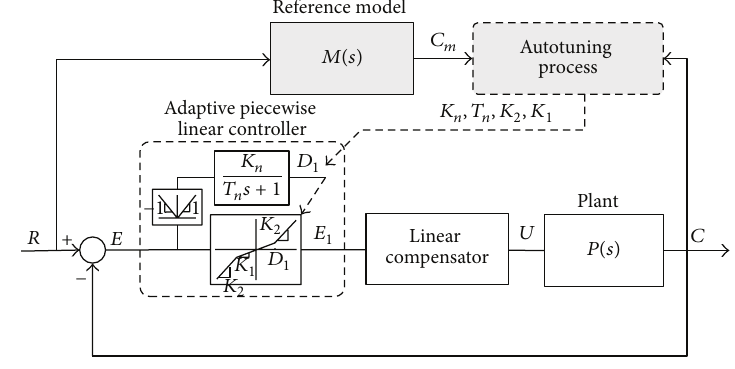
Figure 1: The proposed model based control scheme.